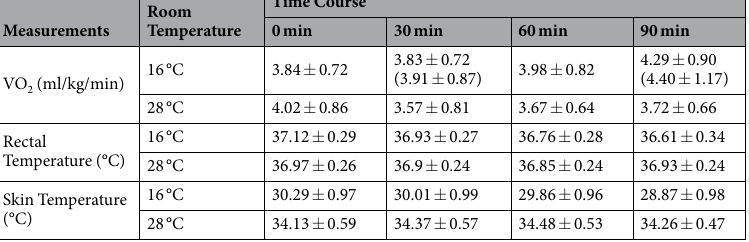
Table 1. Time series variations of physiological data under 16 and 28 degrees Celsius.